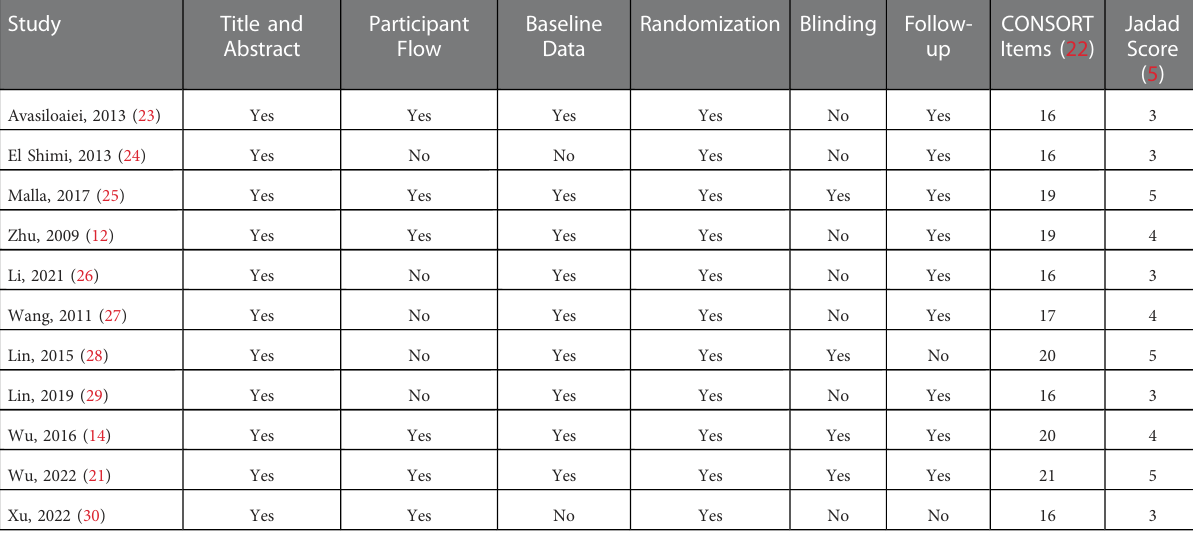
TABLE 2 Report quality of trials included in the